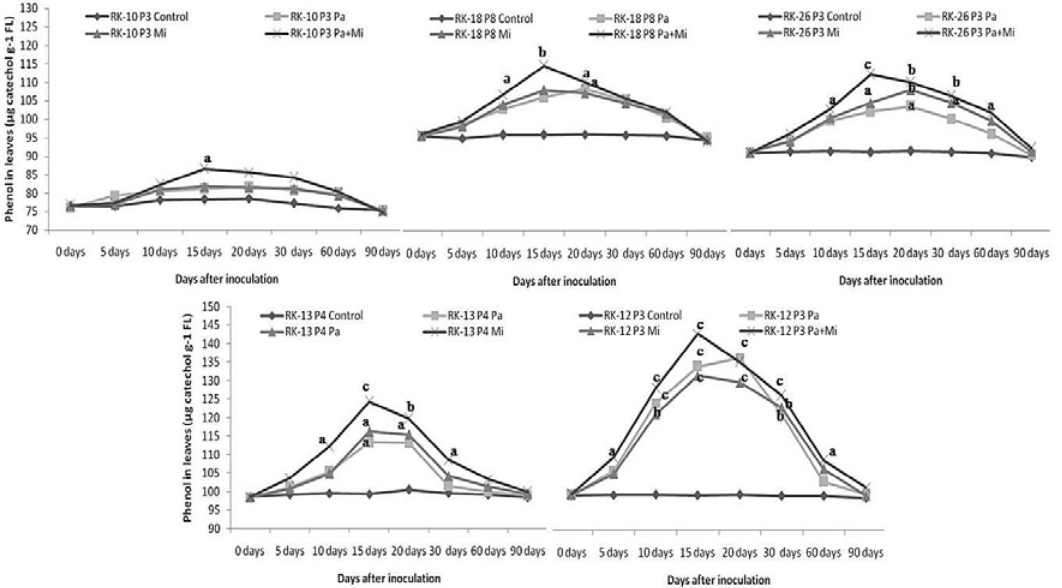
Figure 1. Mean total amounts of phenols in leaves of five tobacco cultivars 0–90 days after inoculation singly and concomi - tantly with Meloidogyne incognita (Mi) or Pythium aphanidertmatum (Pa).. Values followed by a ( P≤ 0.05), b ( P ≤ 0.01) and c ( P≤ 0.001) are significantly different from uninoculate controls. FL, Fresh leaf.